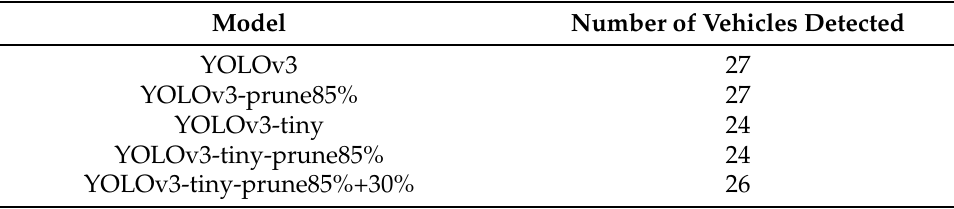
Figure 16. Comparison of detection results. Table 5. Comparison of the numbers of detected